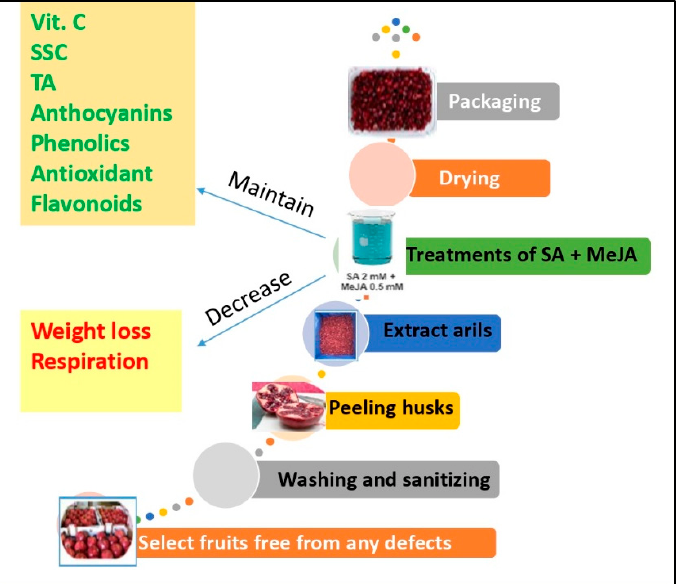
Figure 8. Flowchart of pomegranates processing and effective of SA + MeJA.